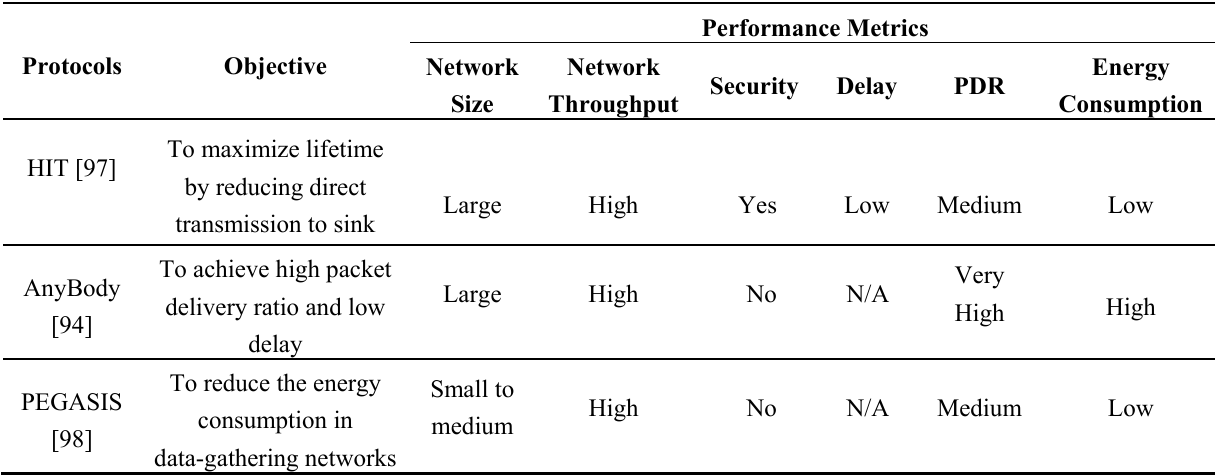
Table 12. Comparison of Clustered-based Routing